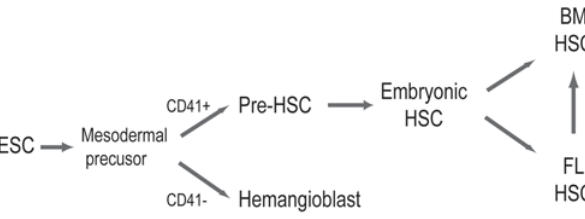
Figure 6. A stepwise developmental model for HSCs. We propose a working model for HSC development. Pre-HSCs originate from mesoderm, possibly independent of hemangioblasts; pre-HSC give rise to embryonic HSCs in particular niches in the YS or P-Sp/AGM region; embryonic HSCs give rise to fetal and adult HSCs in particular niches in the fetal liver and bone